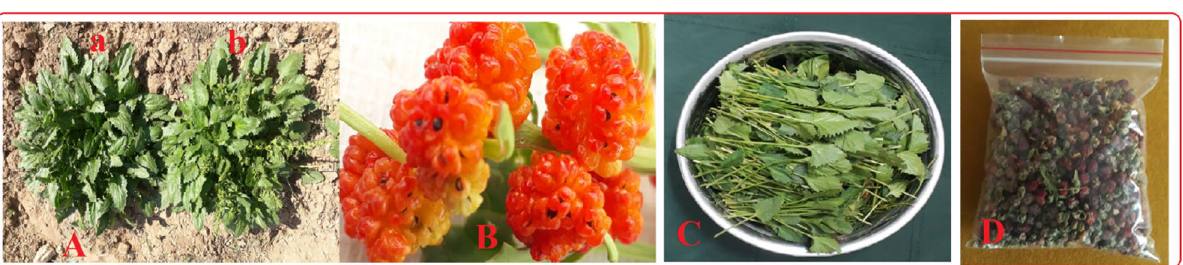
Figure 6. The high yield variety (MSP) resulted from 7 years field mass selection program [( A ) a: vegetative stage and b: generative stage], matured fruits ( B ), harvested leaves of MSP ( C ), and seeds of introduced variety ( D